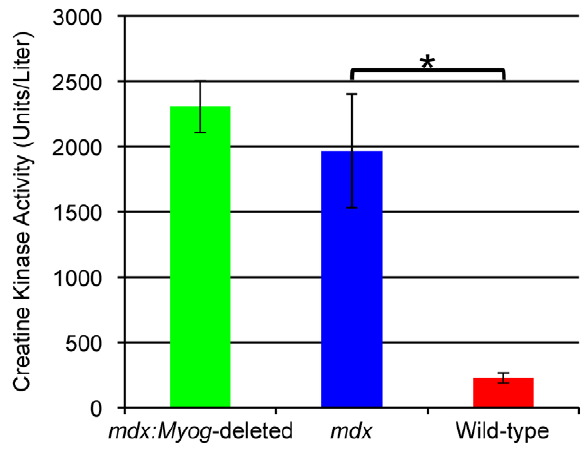
Figure 5. Elevated blood CK levels in mdx and mdx:Myog - deleted mice. A biochemical assay was used to determine the activities of CK in mdx (n=10), mdx:Myog -deleted (n=9), and wild-type (n=6) mice. mdx mice exhibited an elevated level of CK prior to exercise compared to that of wild-type mice. Similarly, mdx:Myog -deleted mice showed elevated levels of CK prior to exercise. Error bars represent 1 standard deviation (* p , 0.05).